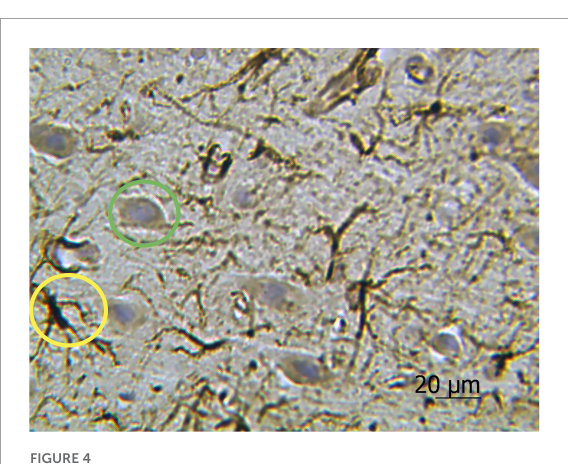
FIGURE4 Rat motor cortex treated with anti-GFAP immunohistochemical reaction with the highlighted examples of protoplasmic astrocytes (yellow circle) and neurons stained with hematoxylin (green circle). Ob. 40x, oc.